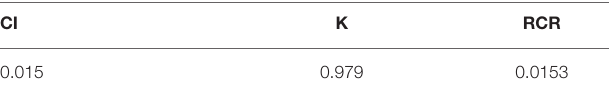
TABLE 5 | The distribution of total weight values consistency. TABLE 6 | Baseline demographic and clinical